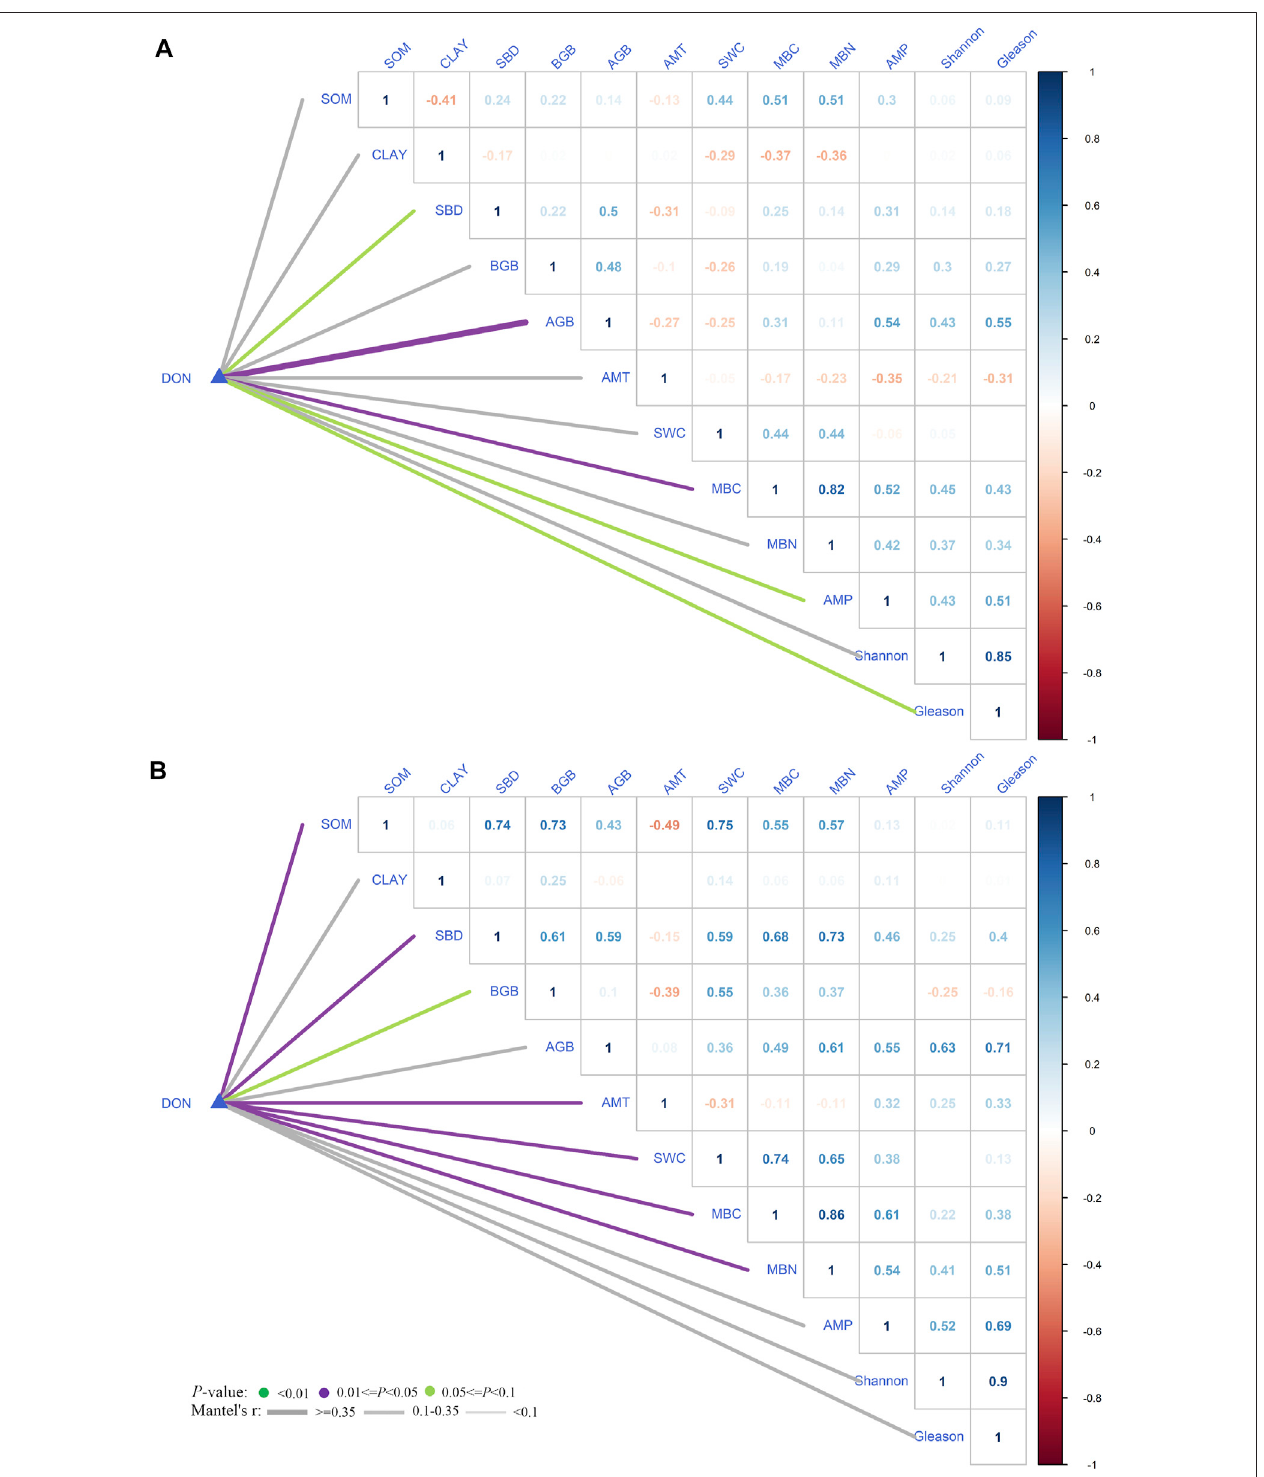
FIGURE 3 | Relationships between dissolved organic nitrogen (DON) and environment and biological factors in the LDON pattern (A) and the HDON pattern (B) , respectively. Environment and biological factors include soil clay (CLAY), annual mean temperature (AMT), annual mean precipitation (AMP), aboveground biomass (AGB), belowground biomass (BGB) community diversity of Shannon – Wiener (Shannon), plant diversity of Gleason (Gleason), soil water content (SWC), soil organic matter (SOM), microbe biomass carbon (MBC), and microbe biomass nitrogen (MBN).